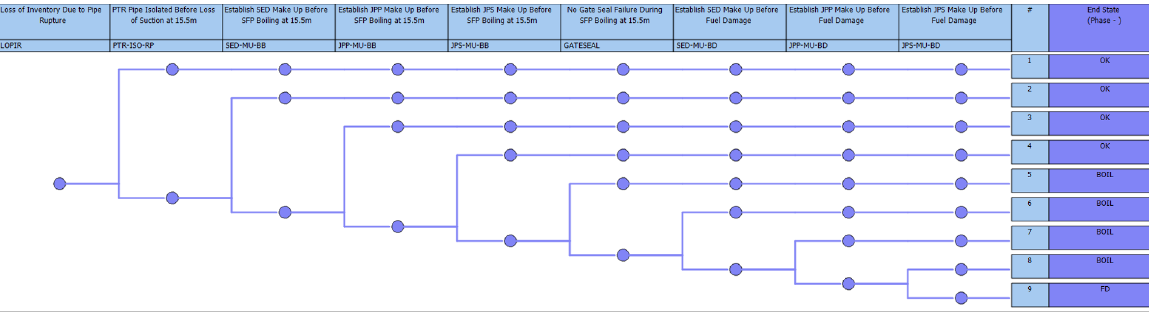
Figure 2. Event tree model of the Loss of Inventory due to Pipe